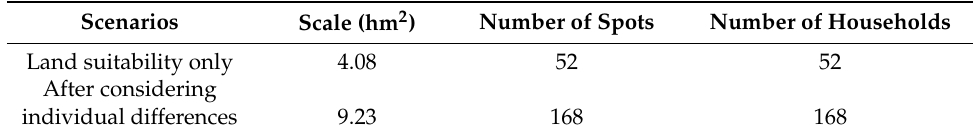
Table 7. Data of rural settlements that need to be optimized.